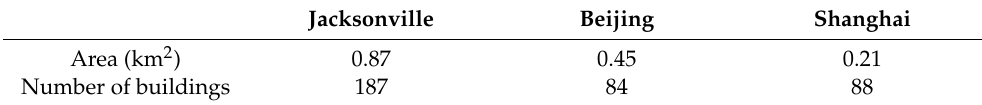
Table 1. The area and the number of buildings in each study region.